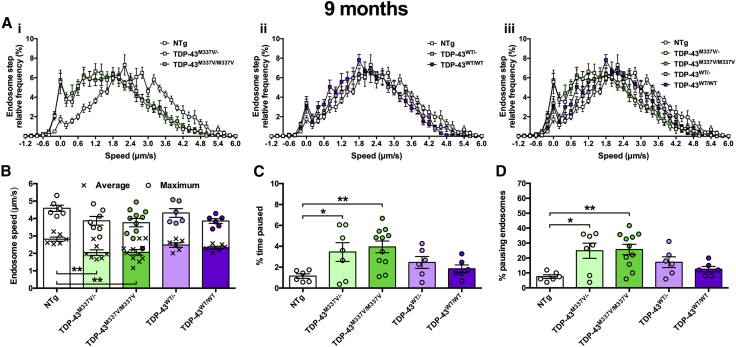
Mutant TDP Mice Display Perturbed Axonal Transport of Endosomes at 9 Months(A) Endosome frame-to-frame speed distribution curves indicate that hemizygous and homozygous TDP-43M337V mice (i, iii, green) transport endosomes more slowly than control, non-transgenic (NTg) mice (white), whereas transport is unaffected in TDP-43WT controls (ii, iii, purple).(B) Mean endosomal speeds (crosses) are significantly reduced in TDP-43M337V/− and TDP-43M337V/M337V mice, but not TDP-43WT controls (p = 0.006, one-way ANOVA), while maximum speeds (circles) remained unchanged (p = 0.0891, one-way ANOVA).(C) Endosomes in mutant TDP-43M337V hemizygous and homozygous mice paused for longer periods of time compared with NTg mice (p = 0.0139, one-way ANOVA).(D) TDP-43M337V mice had a greater percentage of endosomes that paused (p = 0.0046, one-way ANOVA).∗p < 0.05 and ∗∗p < 0.01, Dunnett’s multiple-comparisons test. n = 6–11. Means ± SEM are plotted for all graphs.See also Figures S2 and S4.